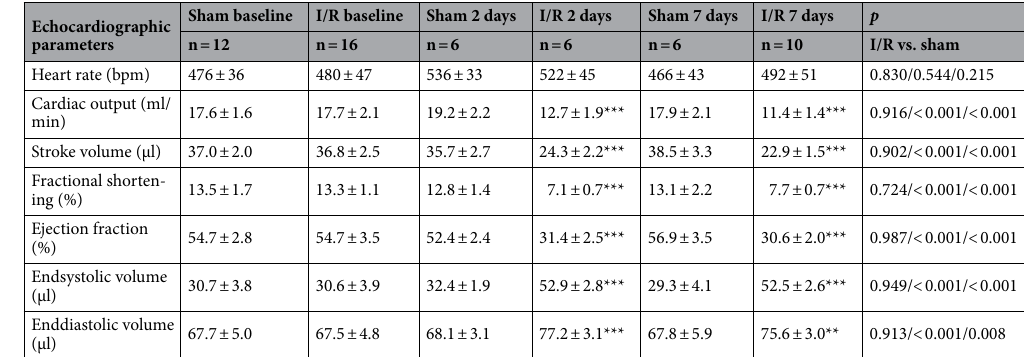
Table 1. Systolic left ventricular function is impaired during the first week after I/R. Data are given as mean ± SD. Statistical significance of differences between I/R and sham control was assessed by unpaired t -test analysis (two-tailed comparison, ** p < 0.01; *** p < 0.001).